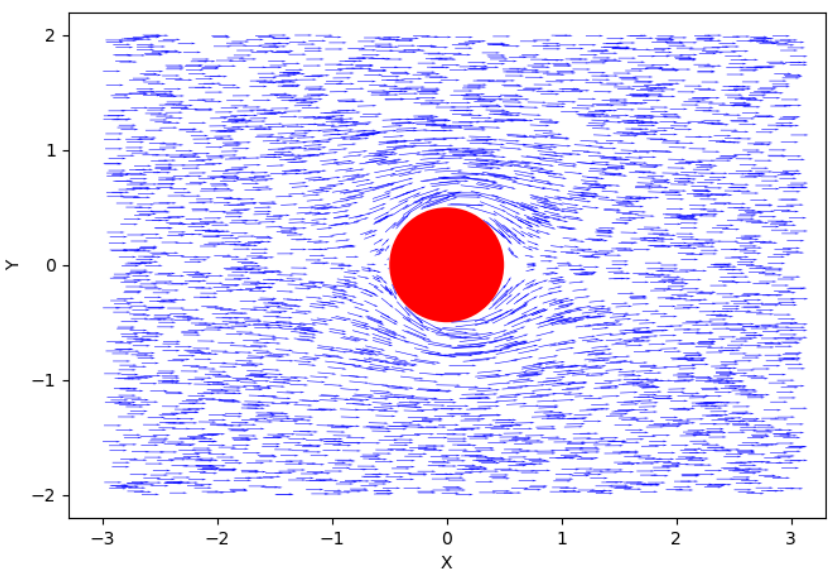
Figure 8. Neural network predicted